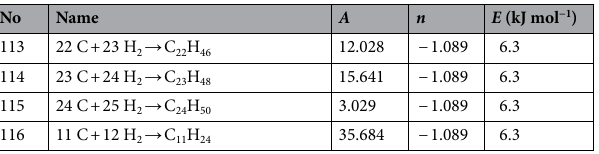
Table 1. Tire pyrolysis reactions with estimated reaction constants to model tire pyrolysis process in the software of Aspen Plus 35